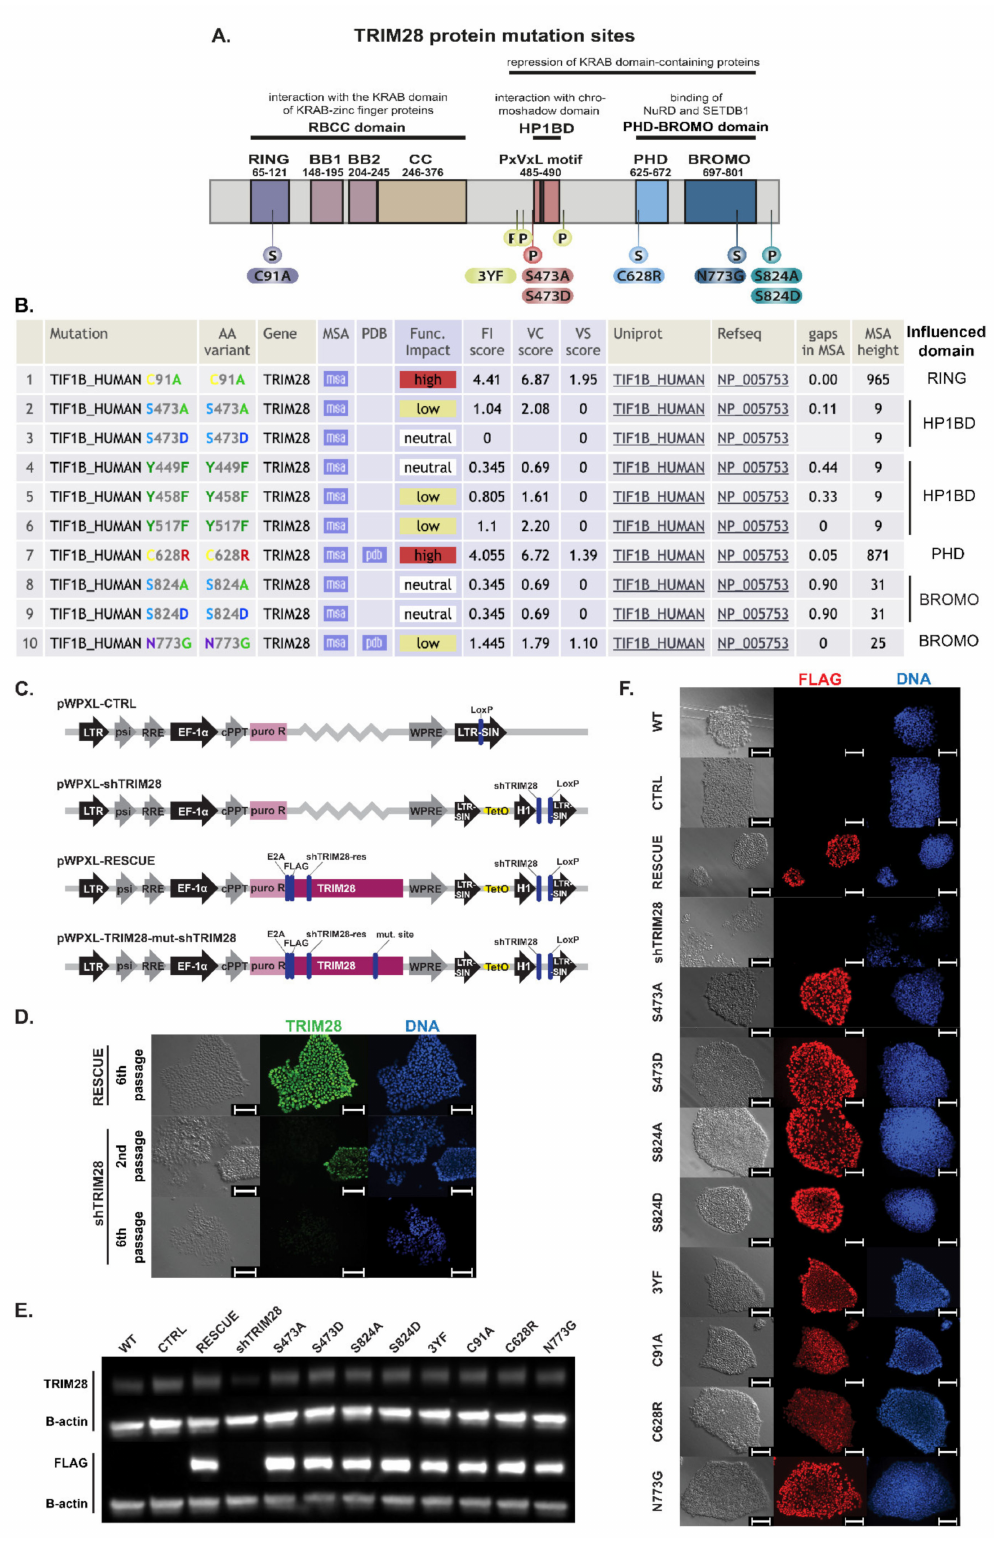
Figure 3. The constructed lentiviral system enables efficient transgene expression and silencing of endogenous TRIM28 . ( A ) Localization of structural (S) or phosphorylation ( p ) mutations cho- sen to affect the function of each TRIM28 domain. ( B ) Prediction of the functional impact of se- lected mutations on TRIM28 activity performed with Mutation Assessor